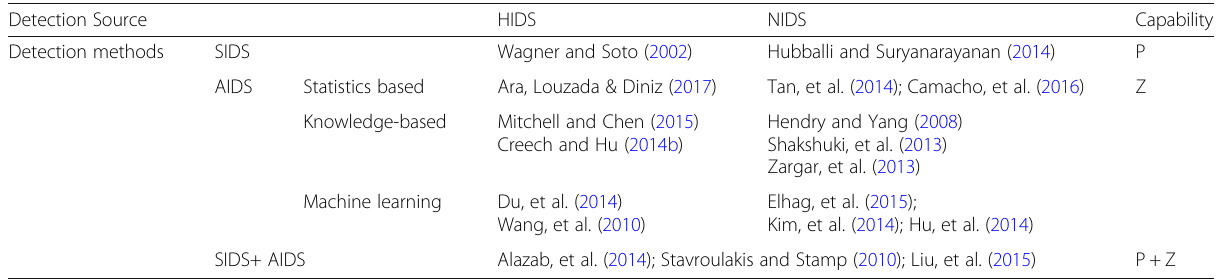
Table 5 Comparisons of IDS technology types, using examples from the literature. “ P ” indicates pre-defined attacks and “ Z ” indicates zero-day attacks